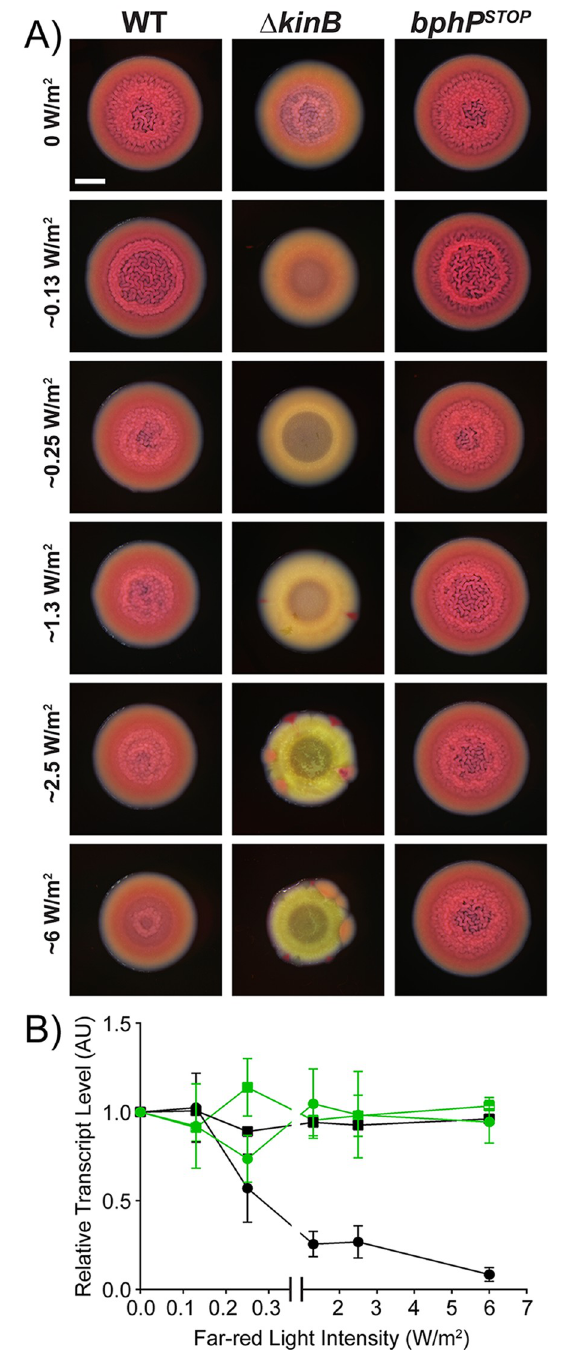
Fig 5. Far-red light intensity controls biofilm formation. (A) Colony biofilm phenotypes are shown for WT PA14 and the designated mutants on Congo red agar medium after 72 h of growth under the indicated far-red light intensities. Scale bar is 2 mm for all images. (B) Relative expression of rpoD (squares) and pelA (circles) measured by qRT-PCR in WT PA14 (black) and in the bphP STOP mutant (green) grown as colony biofilms as in (A). Data were normalized to 16S RNA levels, and the WT levels at 0 mW/m 2 far-red light were set to 1.0. Error bars represent SEM for 3 biological replicates. Data for panel B can be found in supplemental file S1 Data. AU, arbitrary unit; qRT-PCR, quantitative Reverse Transcriptase-Polymerase Chain Reaction; SEM, standard error of the mean; WT, wild type.